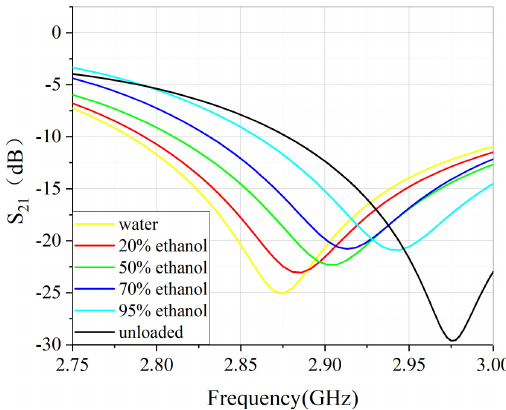
Figure 14. S 21 of different concentration of ethanol.